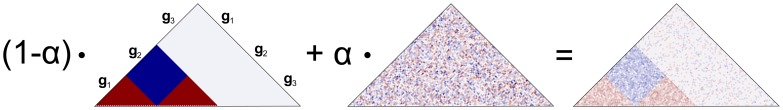
Correlation matrix simulation.In the ‘signal’ matrix (the left triangular matrix), ,  and  represent genes that have positive, negative and random perturbation effects, respectively. Matrix space colored in dark red and dark blue denotes positive and negative association, and white lack of association. These three spaces are filled in Pearson correlation coefficients of 1, −1 and 0, respectively. The ‘noise’ matrix (the middle triangular matrix) is a random correlation matrix generated using function ‘rcorr’ in R package ggm. The correlation matrix (the right triangular matrix) is then generated by a weighted sum of the ‘signal’ matrix and the ‘noise’ correlation matrix.